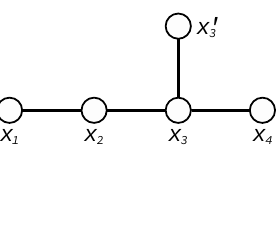
Fig. 2: The graph P +